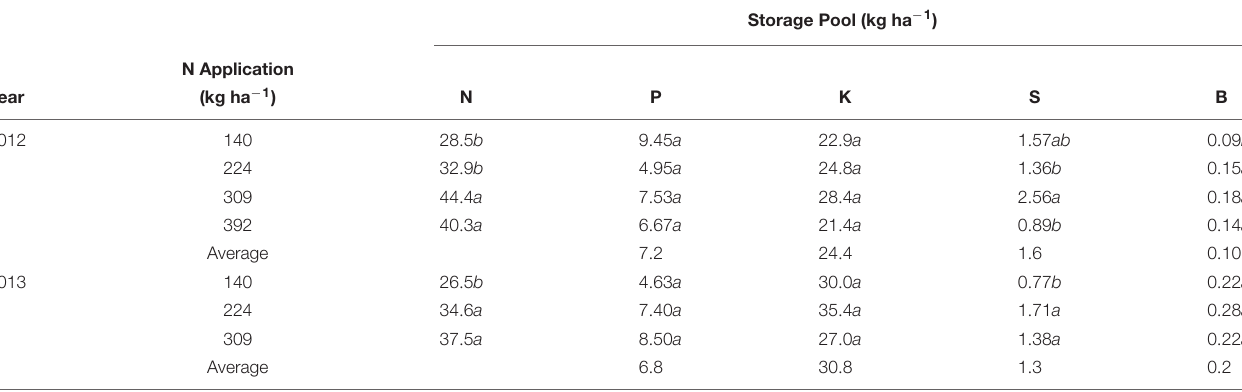
TABLE 4 | Total nitrogen, phosphorus, potassium, sulfur, and boron storage pool (kg ha − 1 ) in perennial biomass of almond trees under differential N application rates calculated as nutrient content when tree is dormant minus lowest nutrient content in perennial tissues during the season.